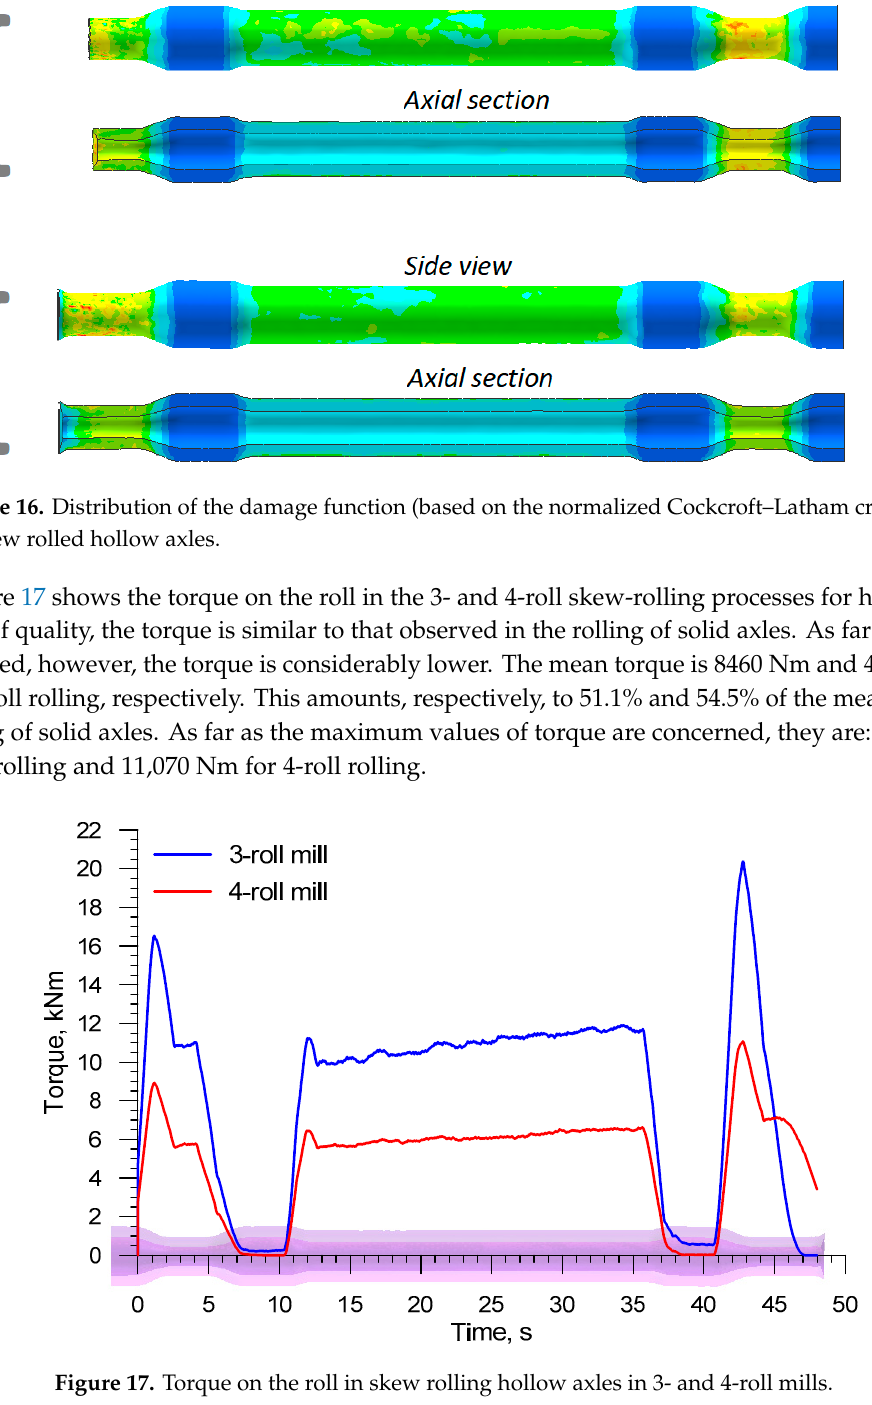
Figure 17. Torque on the roll in skew rolling hollow axles in 3- and 4-roll mills.